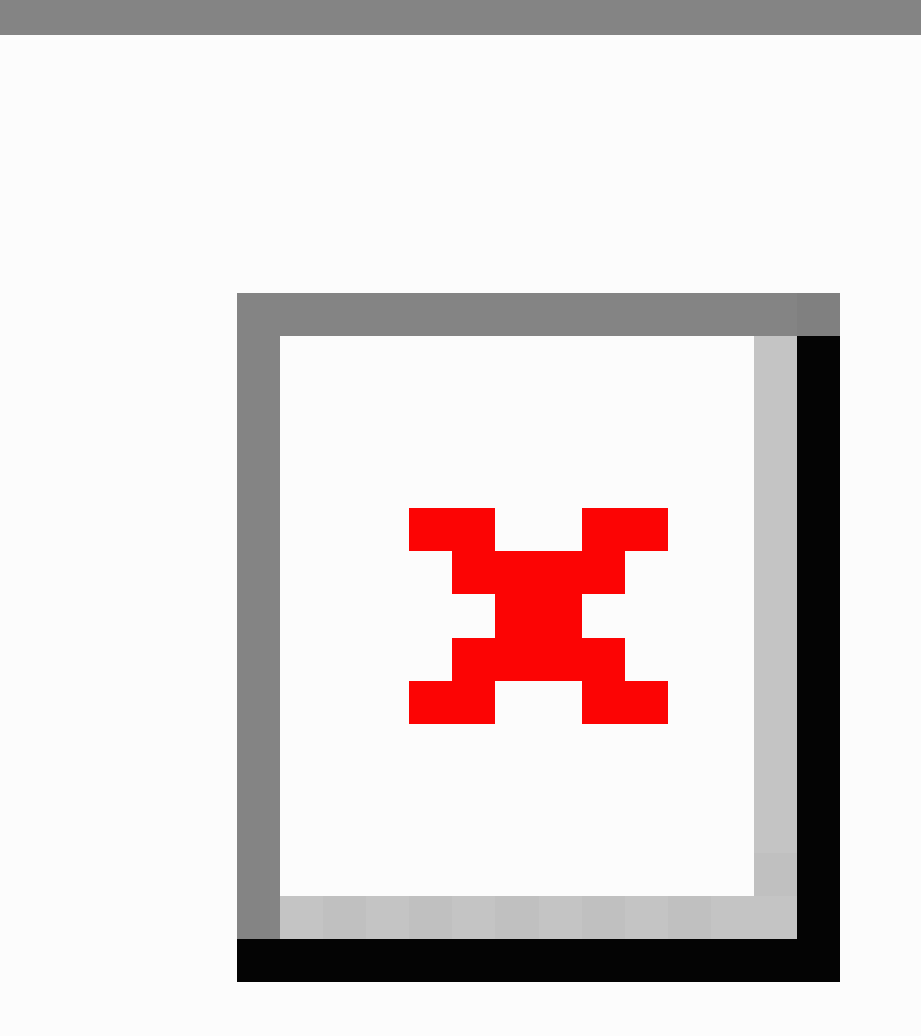
Figure 5. A screenshot of ECG diagnosis using the telesurveillance system. The ECG waveform and the corresponding classification suggestions are revealed on the screen. The suggested heartbeat classification is marked with a blue dot. Health professionals can make decisions using this information in clinical